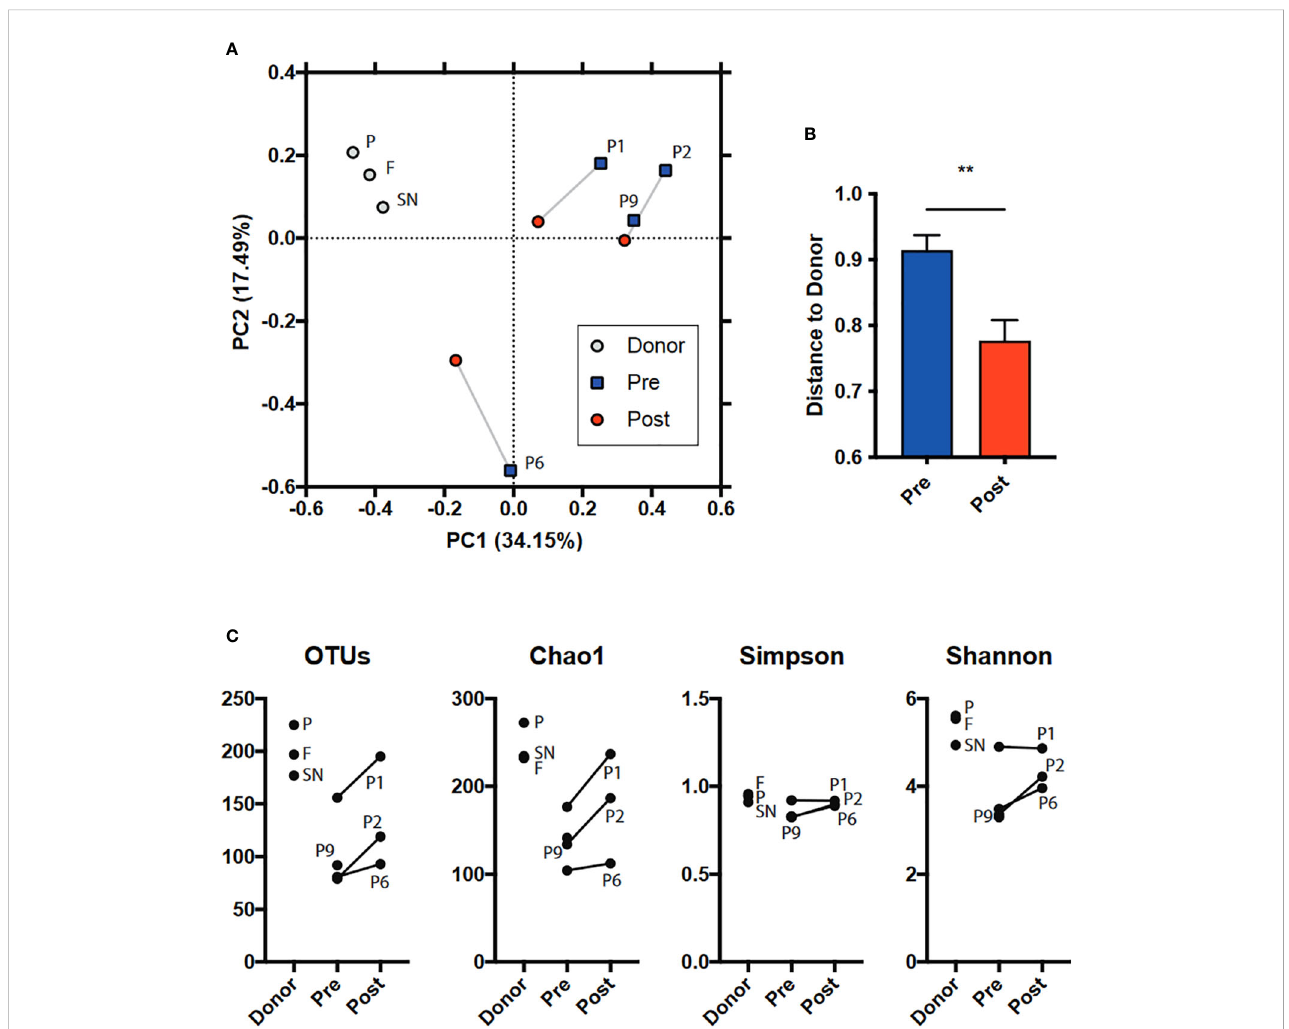
FIGURE 1 Microbiome diversity analysis including (A, B) beta (between samples, PCoA based on BrayCurtis dissimilarity and BC distance of “ pre ” and “ post ” FMT microbiomes to donor) and (C) alpha (within sample, several measures: number of observed OTUs; Chao1, Shannon, Simpson indices). SN: Supernatant. P: Pellet. F: Native faeces. Regarding how the lyophilisates differ from the fresh faeces, the taxonomy overview shows changes in the relative abundances of bacterial taxa during sample preparation and/or lyophilisation (Figure